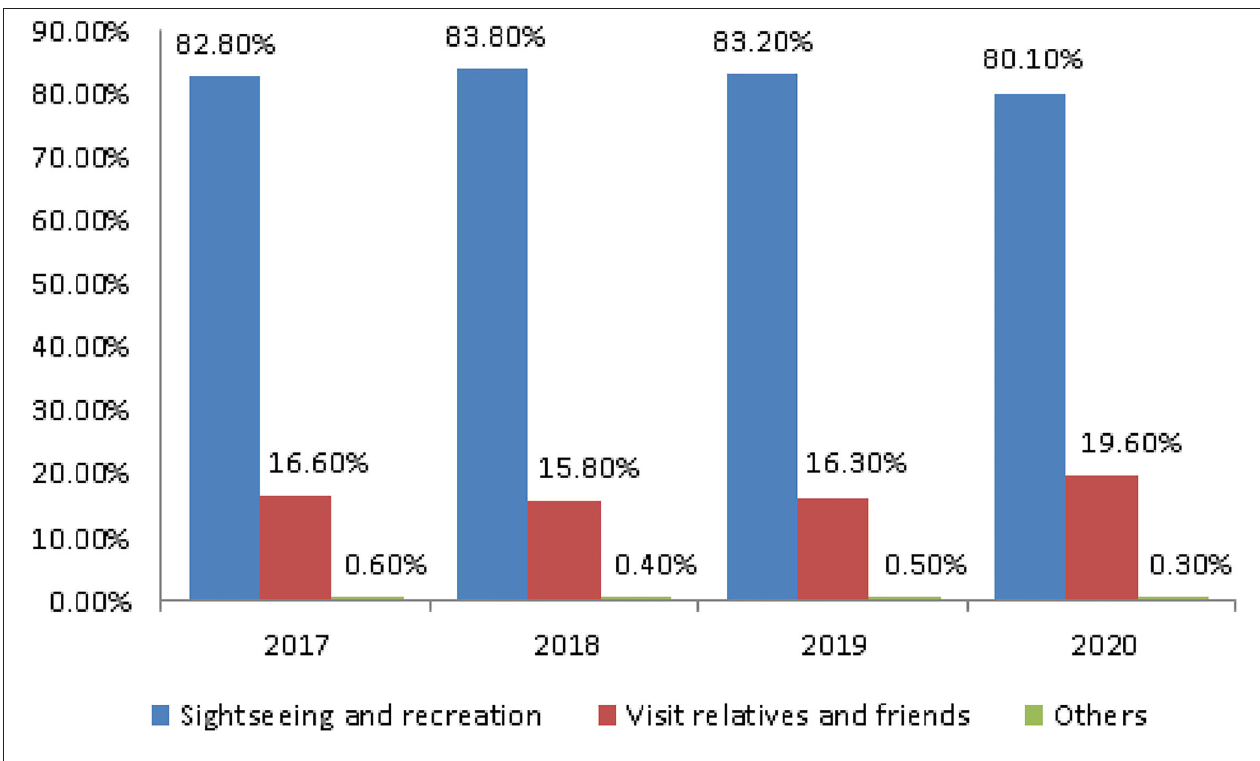
FIGURE 3 | The trend of tourism purpose.